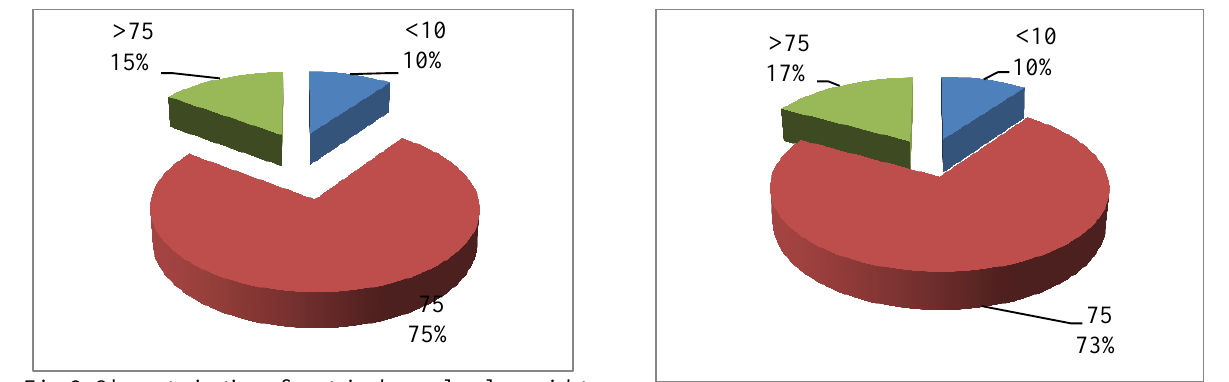
Fig. 2. Characterization of proteins by molecular weight of C. tropicalis , fungi cells obtained with ultrasound